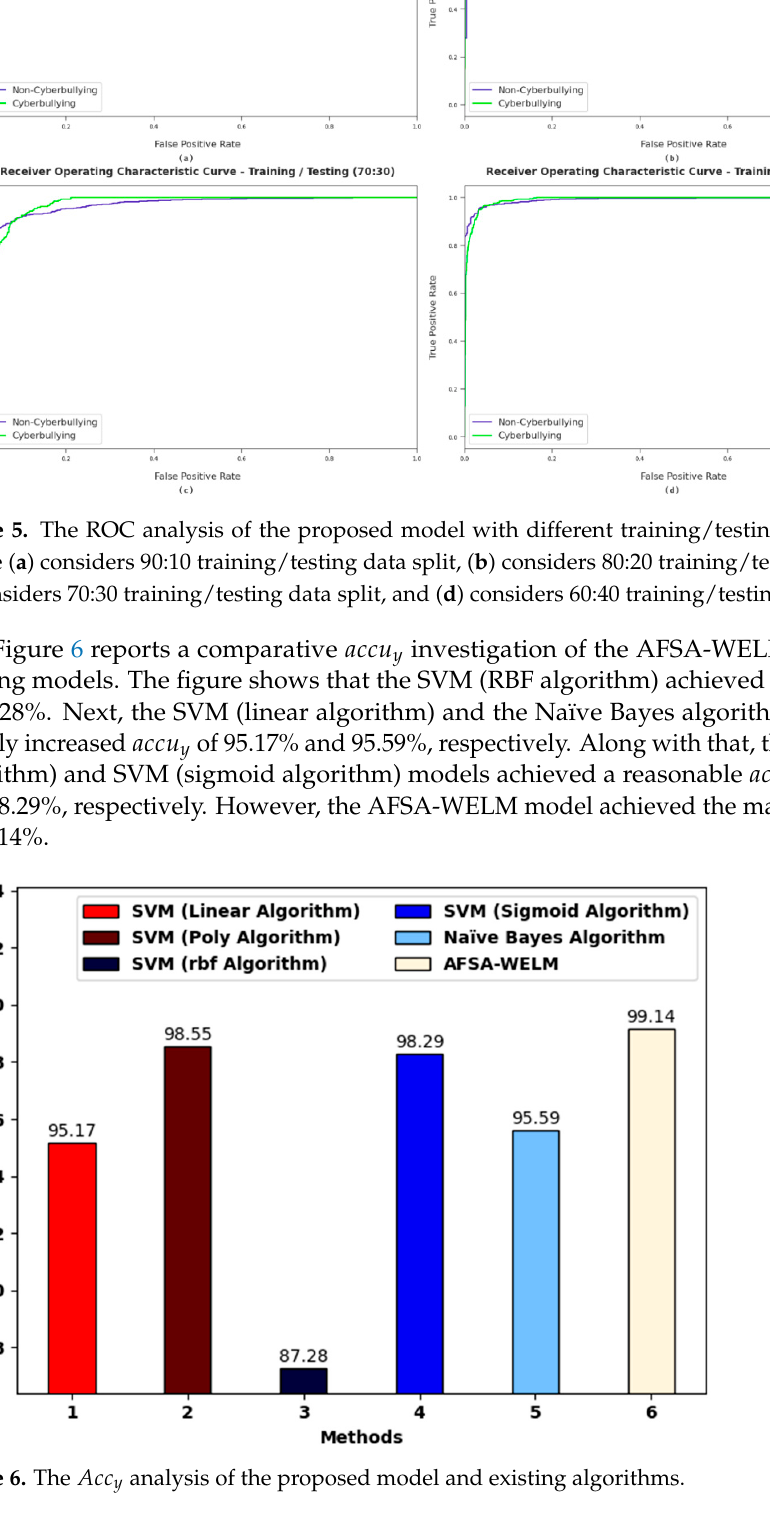
Figure 7. The 𝑃𝑟𝑒𝑐 (cid:3041) analysis of the AFSA-WELM technique and existing algorithms. Figure 8 showcases a comparative 𝑟𝑒𝑐𝑎 (cid:3039) investigation of the proposed method and existing models. The figure shows that the SVM (RBF algorithm) achieved a lower 𝑟𝑒𝑐𝑎 (cid:3039) of 89.67%. Moreover, the SVM (linear algorithm) and the Naïve Bayes algorithm reached a somewhat increased 𝑟𝑒𝑐𝑎 (cid:3039) of 95.07% and 96.70%, correspondingly. At the same time, the SVM (poly-algorithm) and SVM (sigmoid algorithm) models reached a reasonable 𝑟𝑒𝑐𝑎 (cid:3039) of 98.795% and 98.43%, correspondingly. Finally, the proposed model achieved a maximum 𝑟𝑒𝑐𝑎 (cid:3039) of 99.53%.